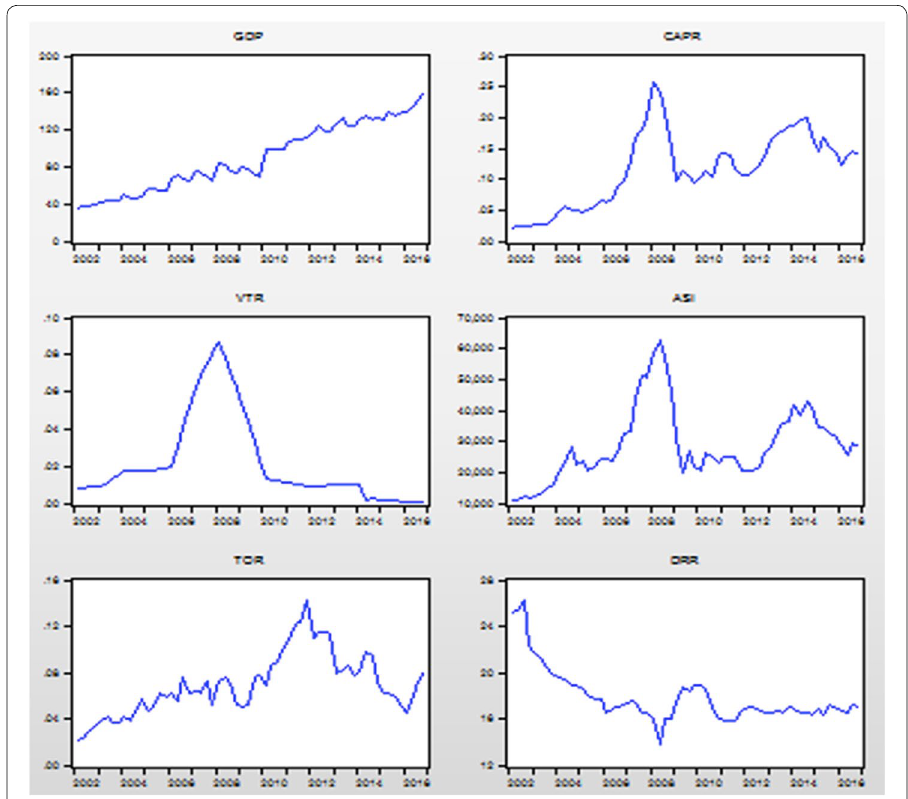
Fig. 4 Trend of aggregate market indicators from 2002 to 2016. Source: Author’s E-views 9.5